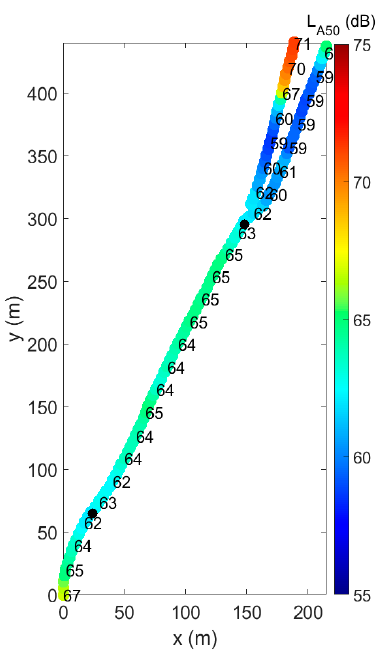
Figure 1. Photographs taken on site: a view towards the berm from the bridge ( left ), and another one along the path itself showing vegetation and the berm ( right ).